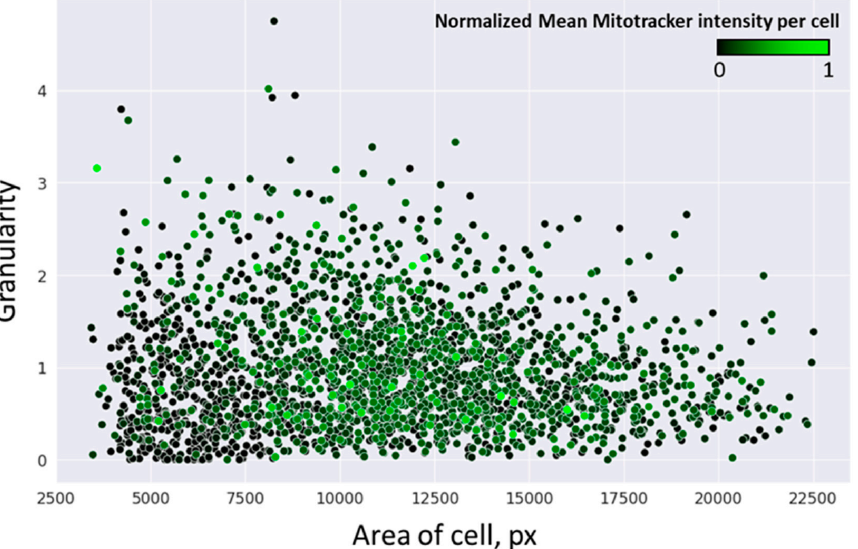
Figure 2. Study of the morphological heterogeneity of human monocytes varying with MitoTracker Orange CMTMRos staining intensity. Each point corresponds to one cell. Values are measured in conventional units and visualized using the CellProfiler